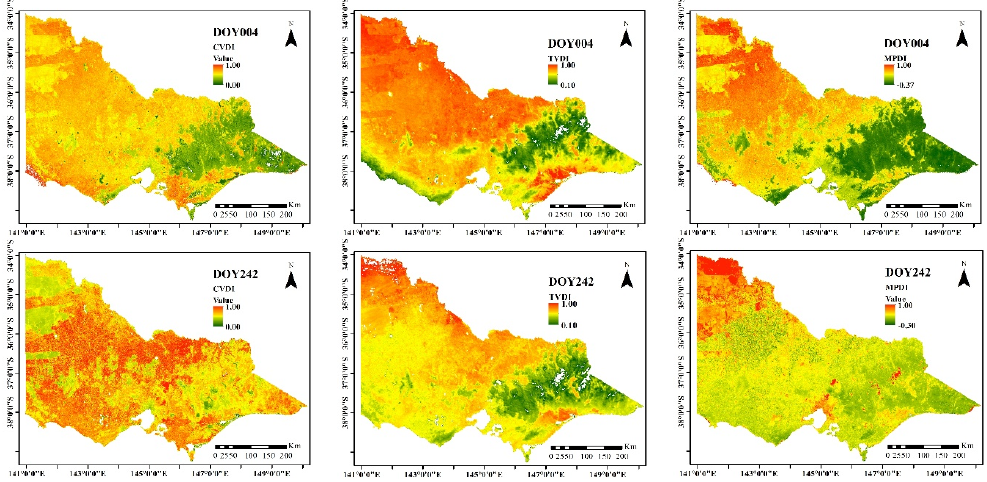
Figure 6. Spatial distribution of the three drought indices on DOY004 and 242. Both the TVDI and CVDI were retrieved under the constraint of dry and wet edges in this study. LST and MPDI adopted to represent water stress between canopy and transpiration in the feature spaces of TVDI and CVDI, respectively. Consequently, in the parameterization scheme of CVDI, there will be an inseparable relationship between MPDI and CVDI. In order to further investigate the relationship between MPDI, TVDI and CVDI, scatterplots between the three indices obtained at the crop sites on DOY004, 242 are demonstrated in Figure 7. Better correlation relationships between MPDI and CVDI are presented than those between TVDI and CVDI in both two days with the difference in R 2 of 0.25 on DOY004 and 0.15 on DOY242. This can partly explain the similar spatial pattern in the distribution of MPDI and CVDI.